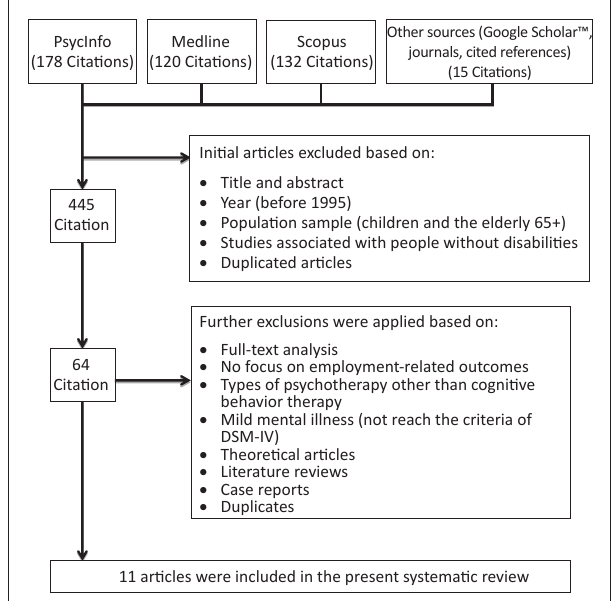
FIGURE 1: Summary of the study-selection process.